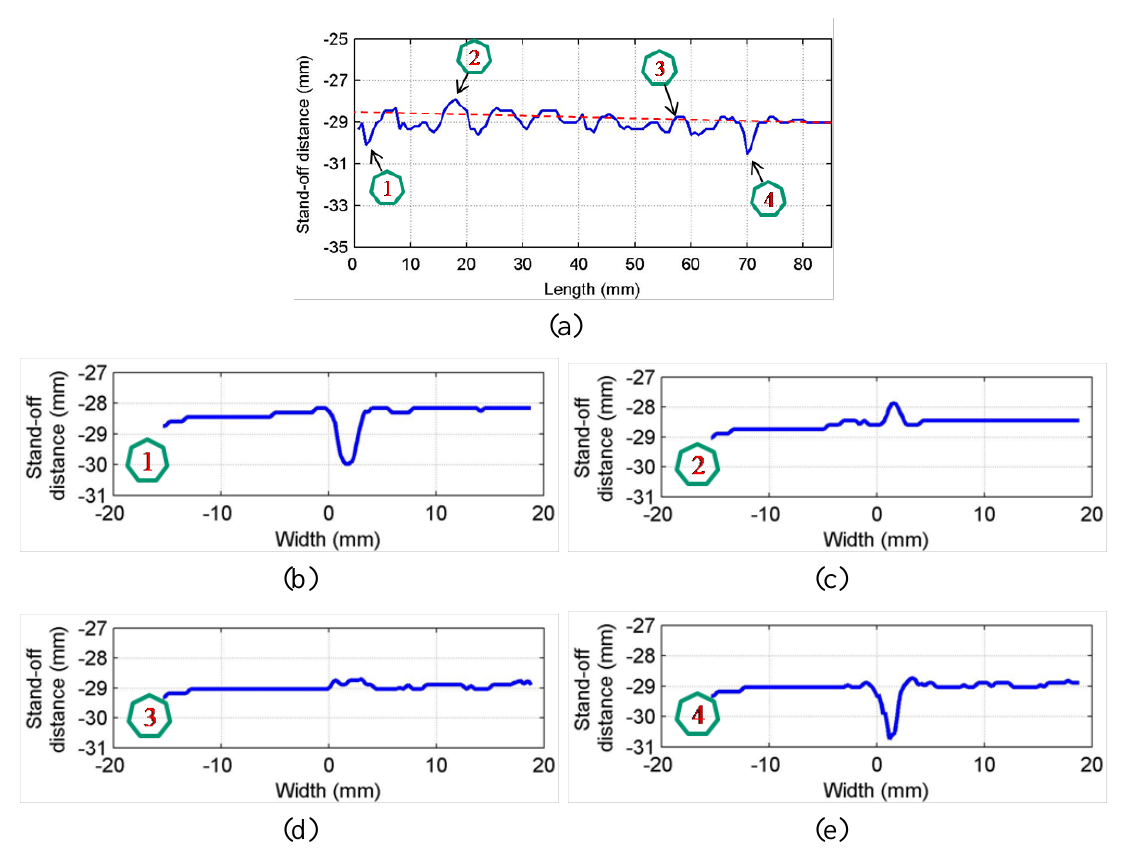
Figure 8. Geometrical evaluation of the inspected weld: (a) longitudinal profile of the weld; (b) traversal profile of the weld at point 1; (c) traversal profile of the weld at point 2; (d) traversal profile of the weld at point 3; (e) traversal profile of the weld at point